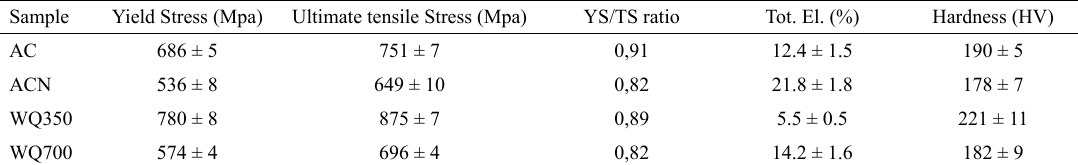
Table 2: The yield, ultimate tensile stress, yield to tensile stress (YS/TS) ratio, elongation and hardness of specimens